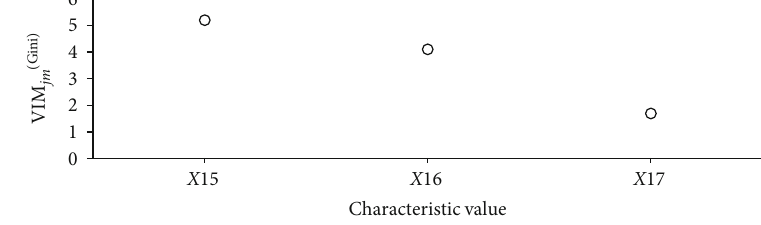
Figure 7: Gini coe ffi cient importance scatter plot of other characteristics.